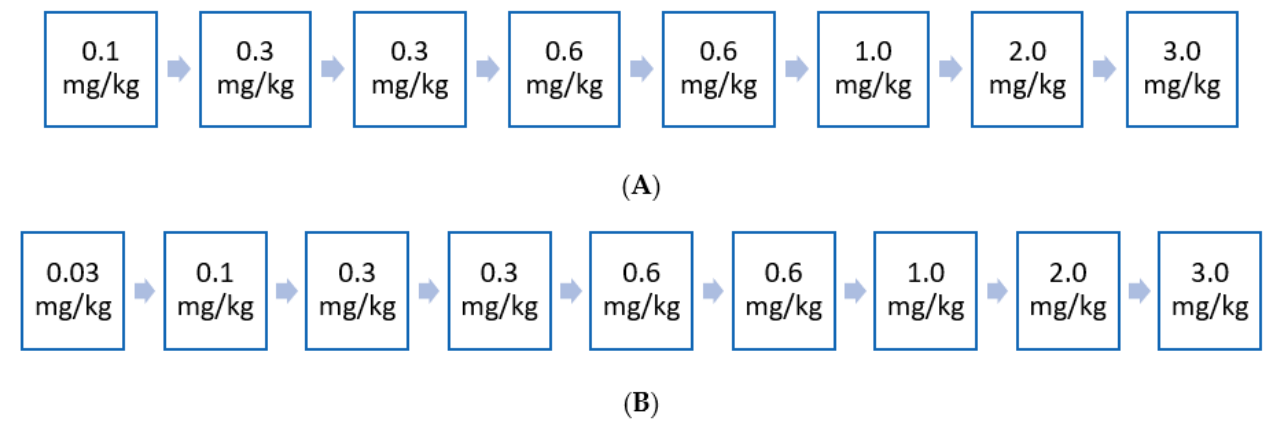
Figure 2. ( A ) Dose escalation regimen for adult patients administered every 2 weeks. Dose-escalation strategy for olipudase alfa after the Phase 1B study [31]. The aim of the dose-escalation process of olipudase alfa is gradual sphingomyelin debulking to prevent high ceramide release. BMI, body mass index. ( B ) Dose escalation regimen for pediatric patients administered every 2 weeks. Dose escalation regimen of olipudase alfa phase I/II ASCEND PEDS [27].